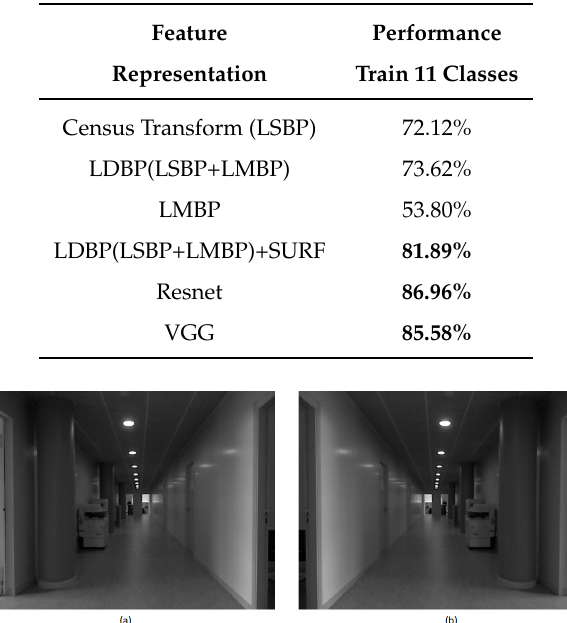
Table 2. Performance of an SVM Classifier with different feature representations and using augmented test sets with symmetrical images.